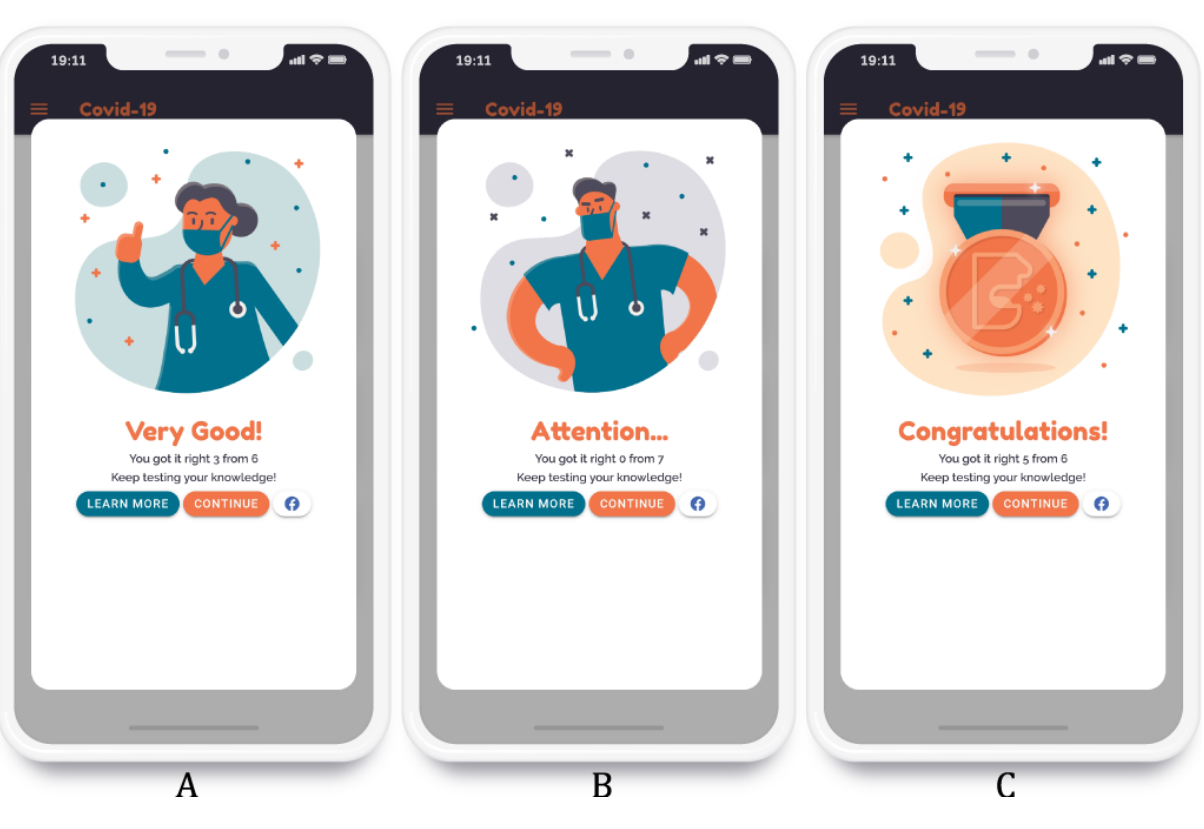
Figure 4. Cards with results (A, B) and medal (C) for a topic.